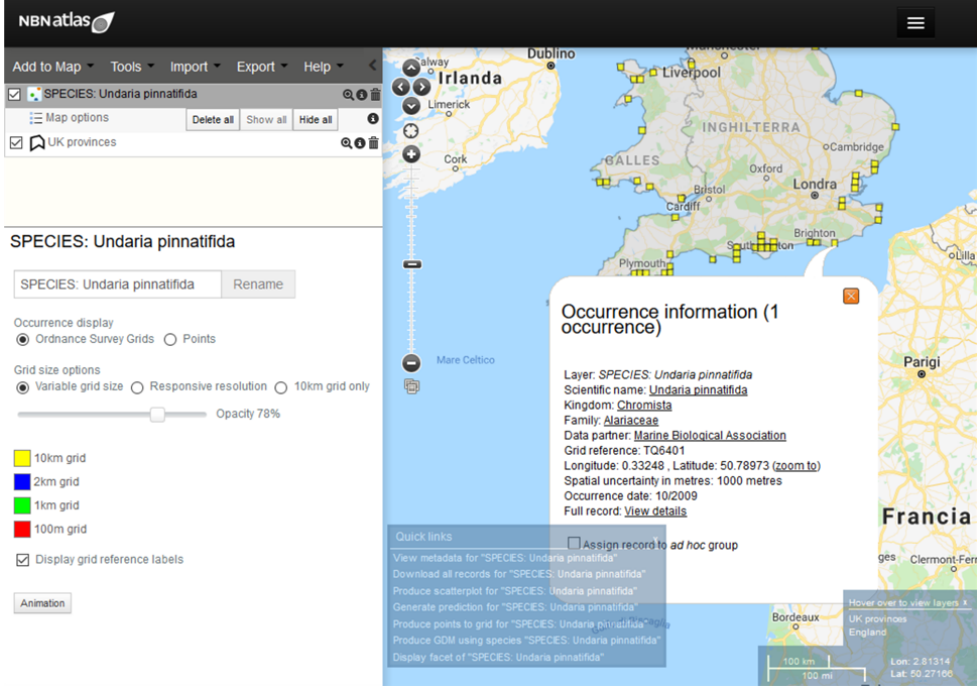
Figure 10. A view of the National Biodiversity Network (NBN) Atlas analysis portal, showing data collected within the Wakame Watch project.